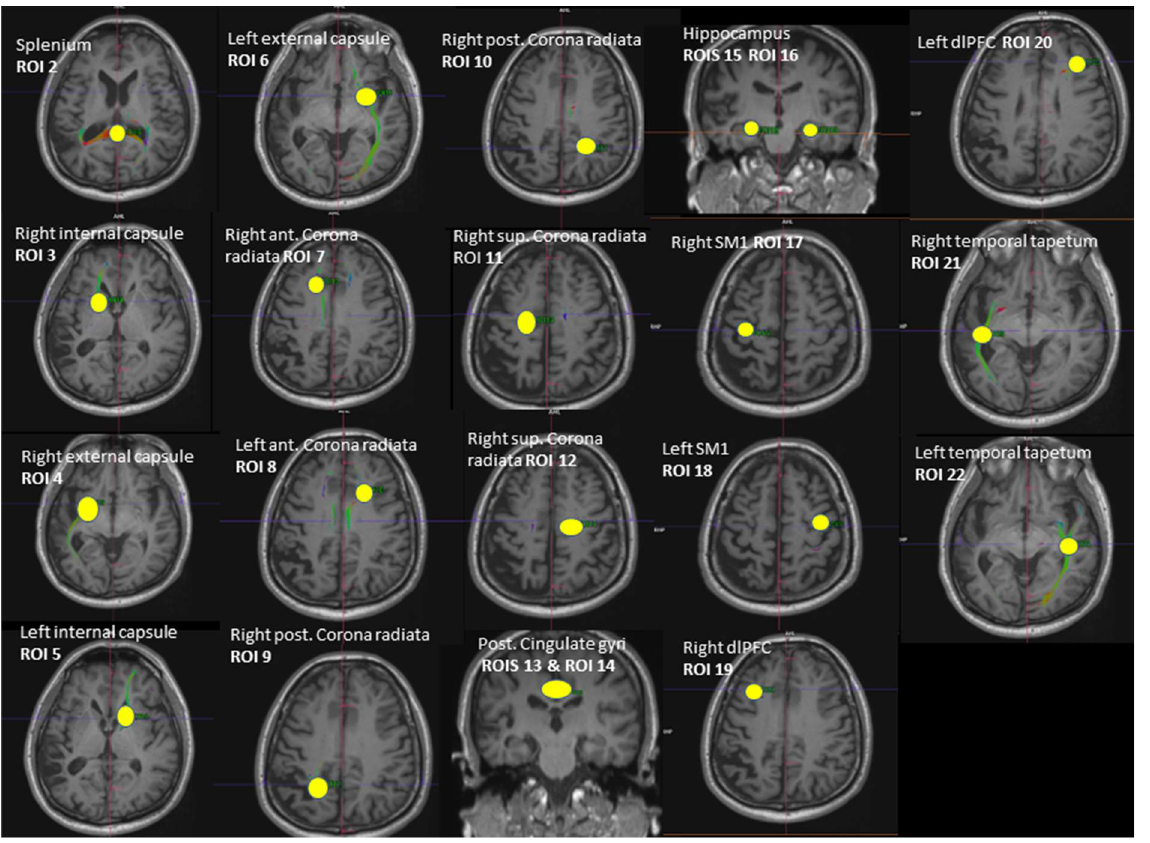
Figure 2. Illustration of the 21 regions of interest (ROIs) used as seed regions for tractography. Voxels of MRS: ROI 13—right dPCC, ROI 18—left SM1, ROI 16—left hippocampus, ROI 22—left MTC, ROI 19—right dlPFC. ROI = region of interest, dPCC = dorsal posterior cingulate cortex, MTC = middle temporal cortex, dlPFC = dorsolateral prefrontal cortex, SM1 = sensorimotor